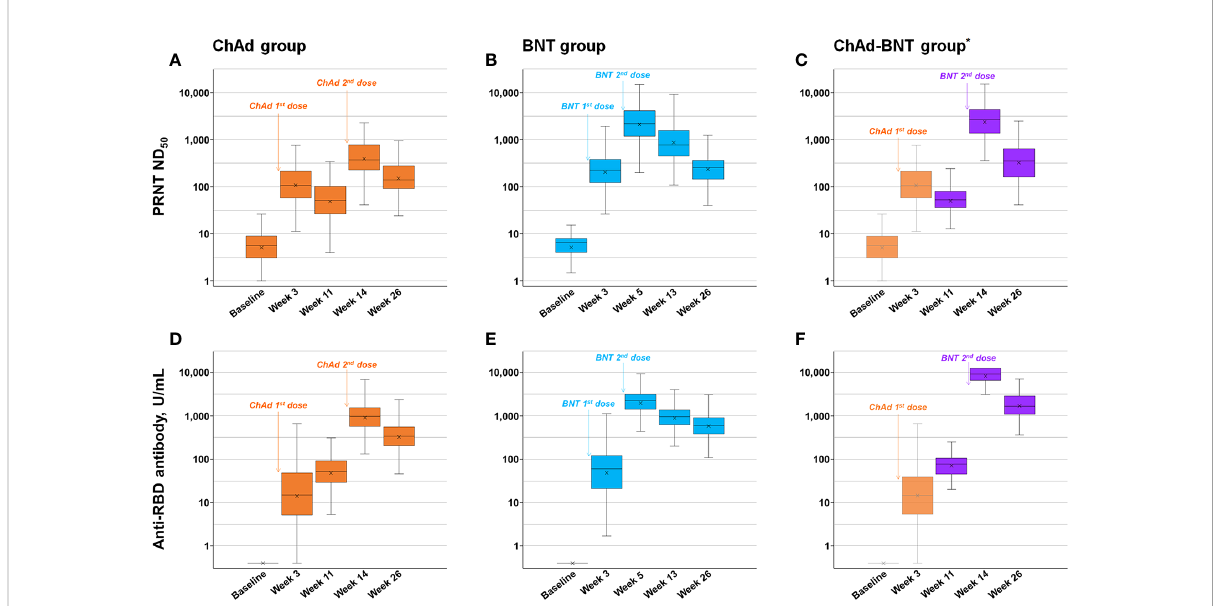
FIGURE 2 Measured neutralizing and anti-RBD antibody levels. Measured neutralizing antibody levels of ChAd (A) , BNT (B) , and ChAd-BNT (C) groups and anti-RBD antibody levels of ChAd (D) , BNT (E) , and ChAd-BNT (F) groups are depicted. *Because the ChAd-BNT group was enrolled later, the baseline and week 3 antibody levels of the ChAd-BNT group were adopted from the ChAd group. ChAd, AZD1222 ChAdOx1 vaccine; BNT, BNT162b2 vaccine; PRNT, plaque-reduction neutralizing test; ND 50 , 50% neutralizing dose; RBD, receptor binding